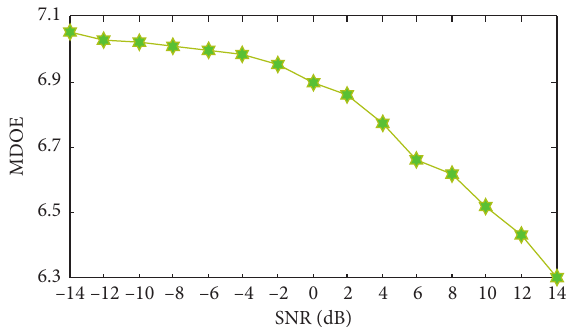
Figure 4: The MDOE indicators with regard to different